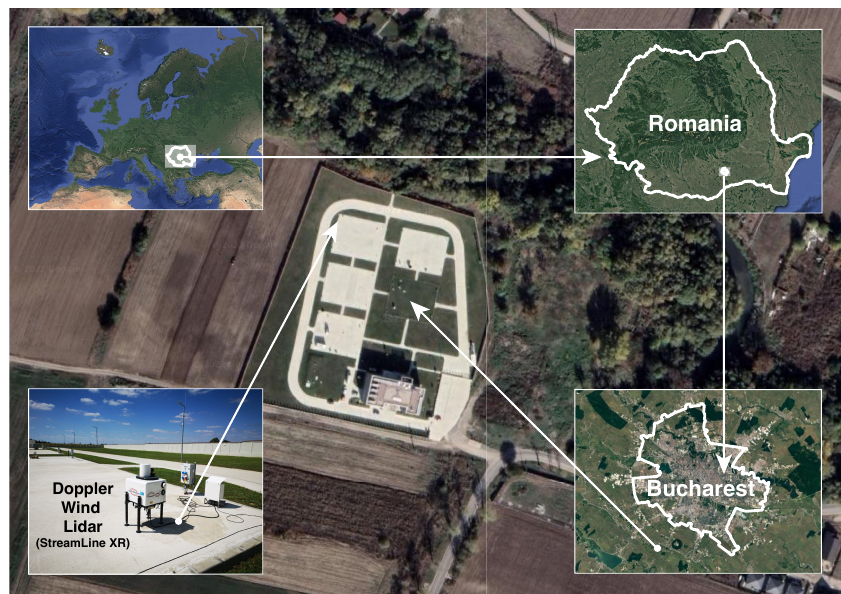
Figure 1. StreamLine XR Doppler wind lidar located at the M˘agurele Center for Atmosphere and Radiation Studies (MARS), M˘agurele, Romania. Based on Google Maps (map data: Google, Maxar Technologies) processed on QGIS